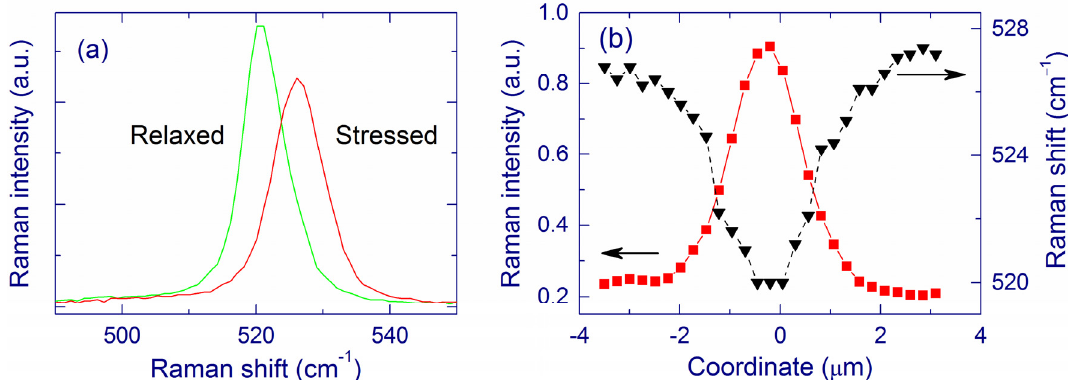
Figure 19. ( a ) Raman spectra of Si-nc with stress of ~3 GPa and after laser-induced relaxation (for 2- μ m-thick Si/SiO 2 SL). ( b ) Cross-sections of the Raman band position and Raman intensity integrated in the 510–520 cm − 1 region. Reproduced with permission from [151]. Copyright 2009, AIP Publishing